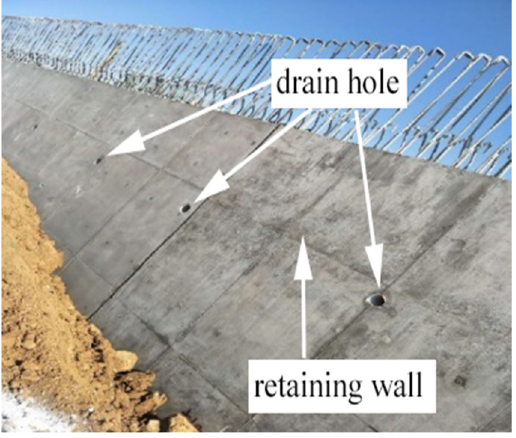
Figure 2. An arrangement diagram of the drainage pipe in the retaining wall.